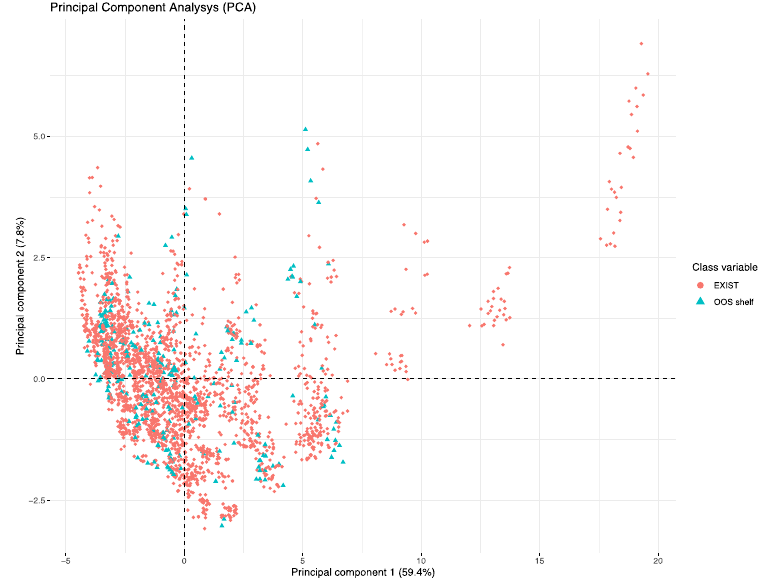
Figure 5. Exploratory Data Analysis (EDA) on DS.CS_2 Dataset. Relationship between predictor variables and class vari- able: ( a ) Average inventory level in a period vs. Average number of items sold in a period; ( b ) PO reception qty (deliver): number of items to deliver in a period to D.C. for a specific store.